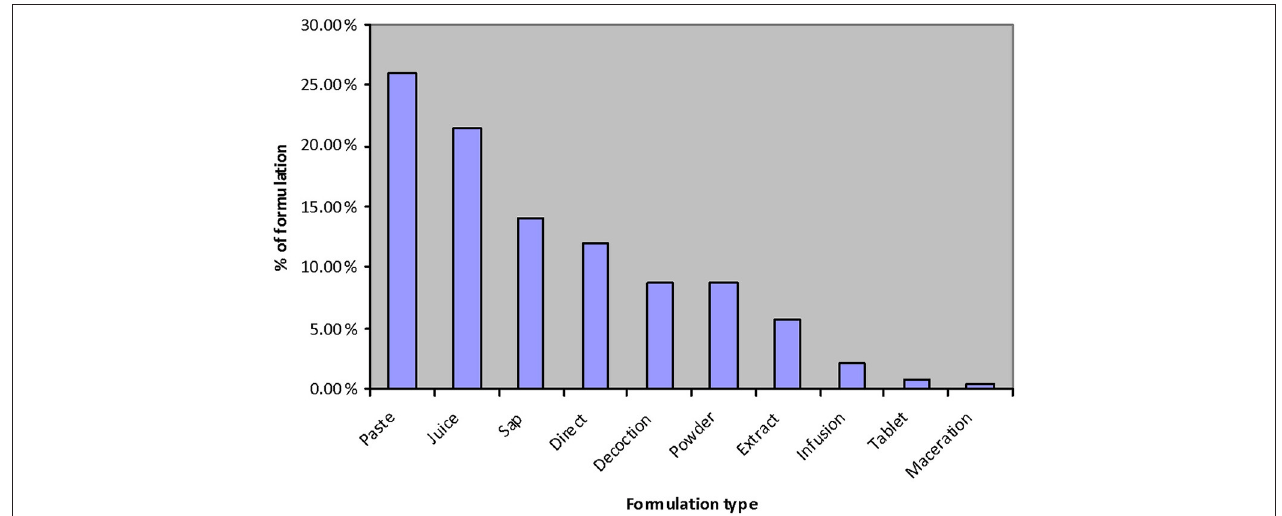
FIGURE 3 | Mode of preparation of